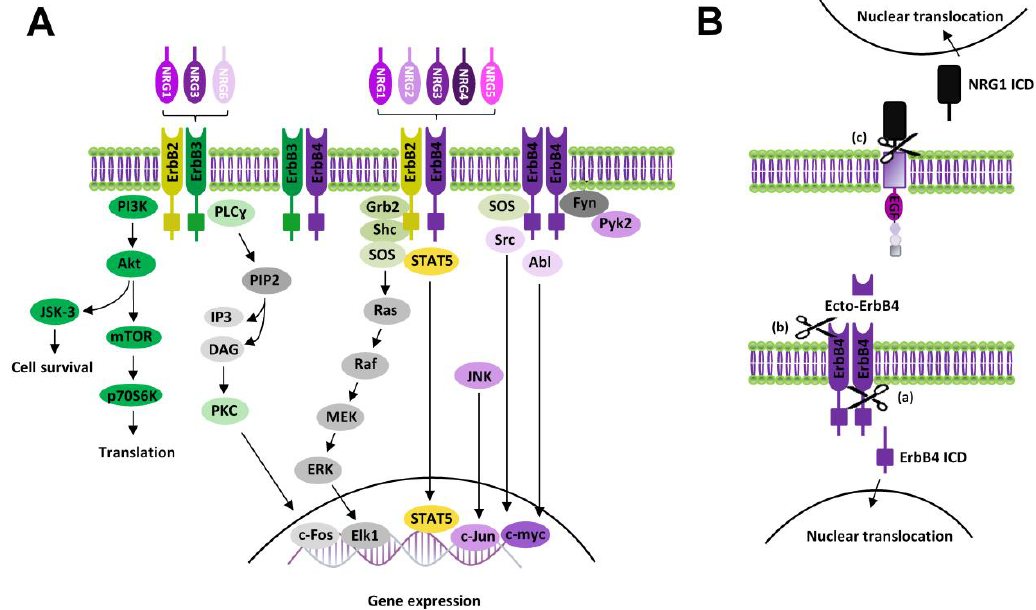
Figure 2. NRGs/ErbB signaling. ( A ) Diagram showing canonical ErbB signaling pathways